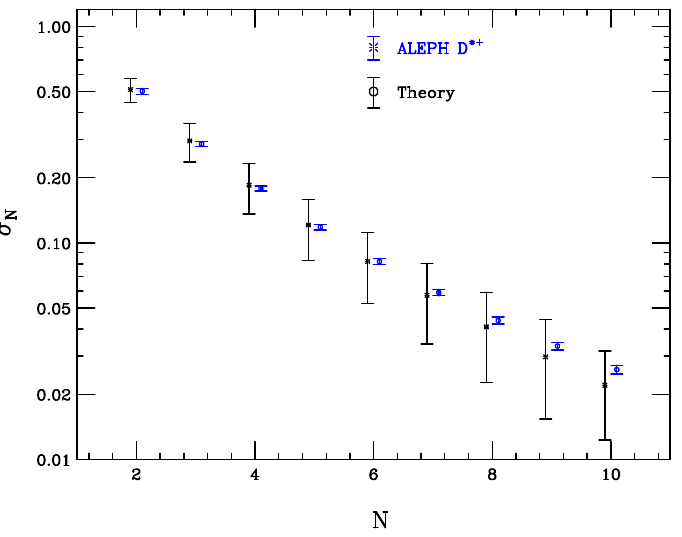
Figure 6. Charmed-hadron production cross section in N -space according to the effective-coupling model (denoted by ‘Theory’) described in the text, compared with the ALEPH moments for D ∗ + production. The theory errors are computed as discussed in [21].